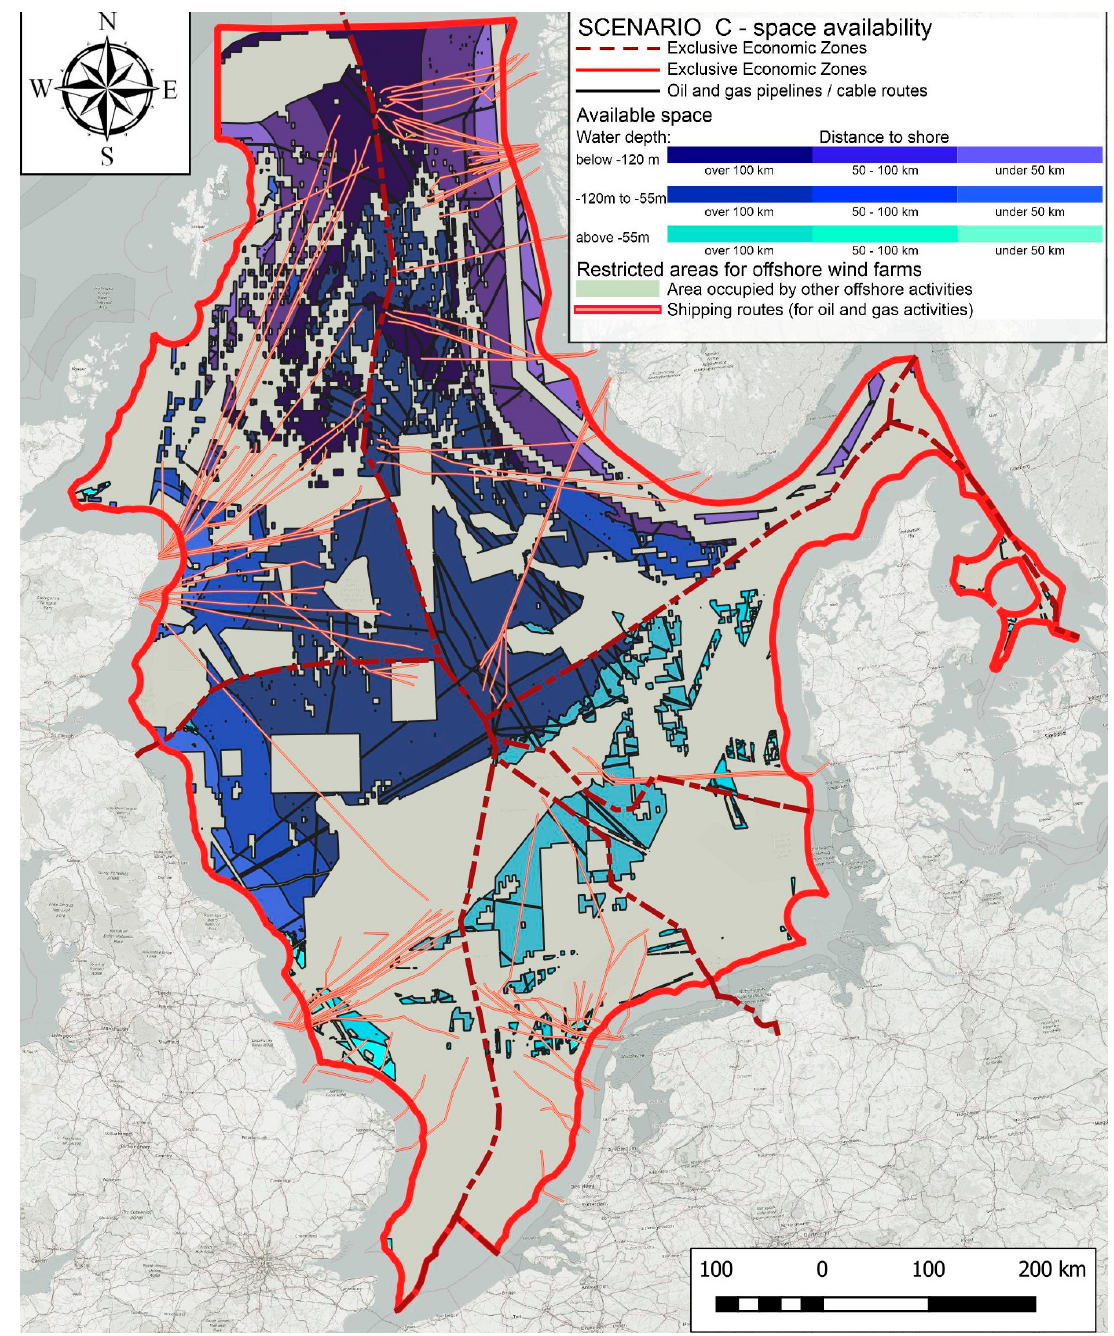
Figure 9. Scenario C: low renewable energy ambitions/sectoral planning. Table 11. Available space—Scenario C.